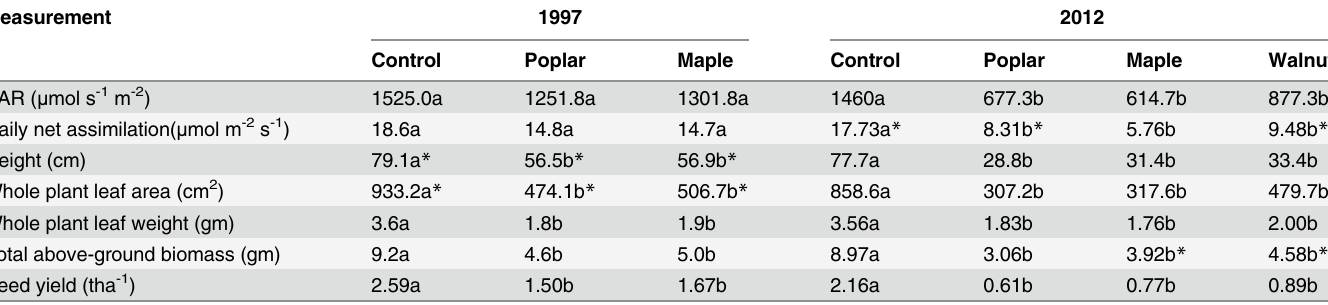
Table 2. Differences in measured parameters associated with soybean plants in three intercropping treatments and monoculture control 12 (1997) and 26 (2012) years after establishing poplar, maple and walnut intercropping systems. Measurement